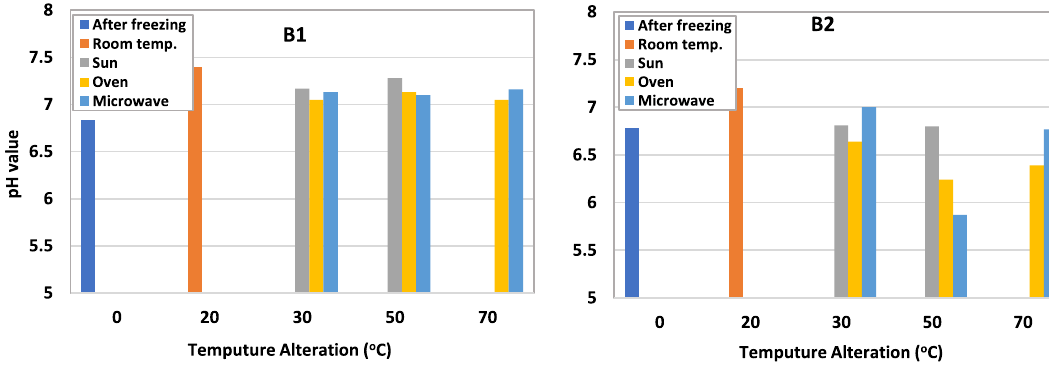
Fig. 1 pH values at different heating degrees for brands B1 and